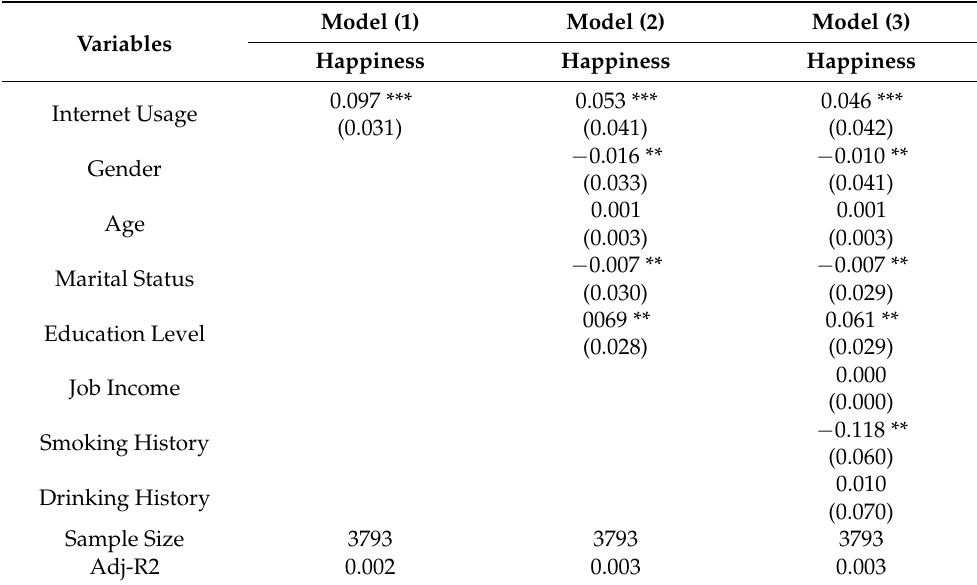
Table 4. Robustness test results of Internet use on civil servants’